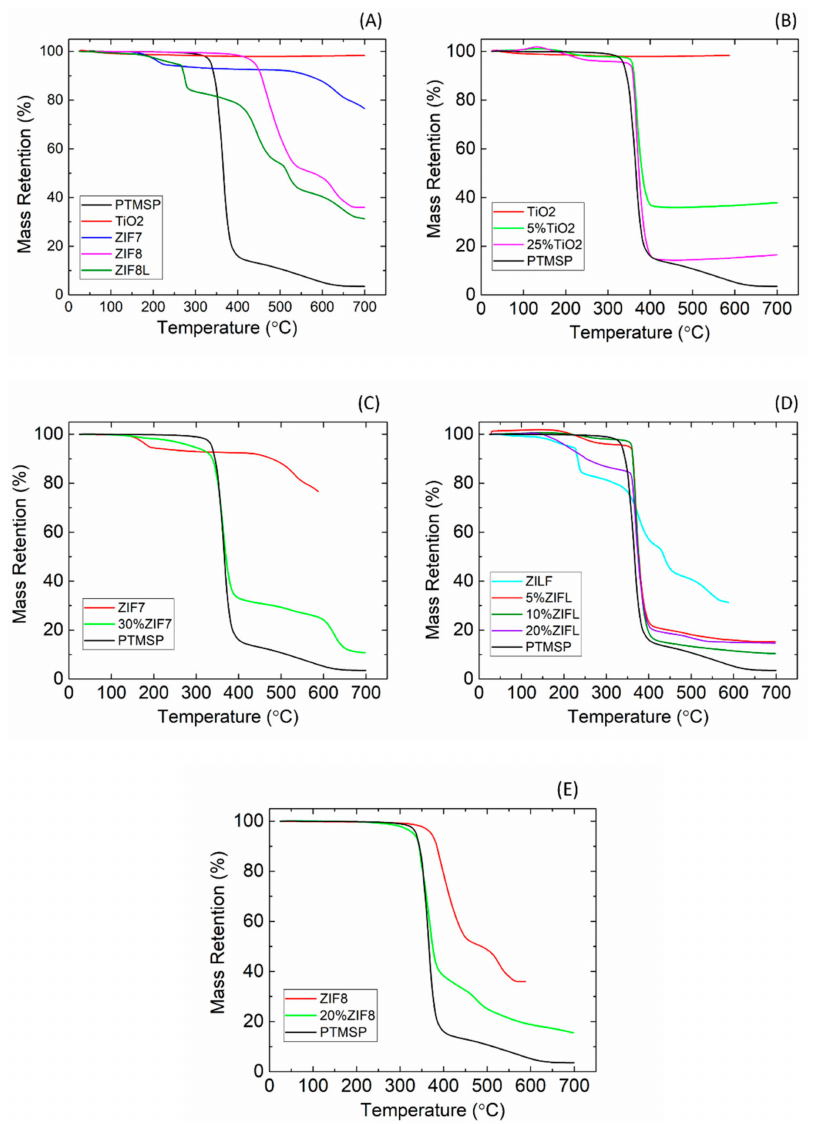
Figure 5. TGA results of neat PTMSP polymer and different nanoparticles ( A ), TGA curves of PTMSP/TiO 2 ( B ), PTMSP/ZIF-7 ( C ), PTMSP/ZIF-L ( D ), and PTMSP/ZIF-8 ( E